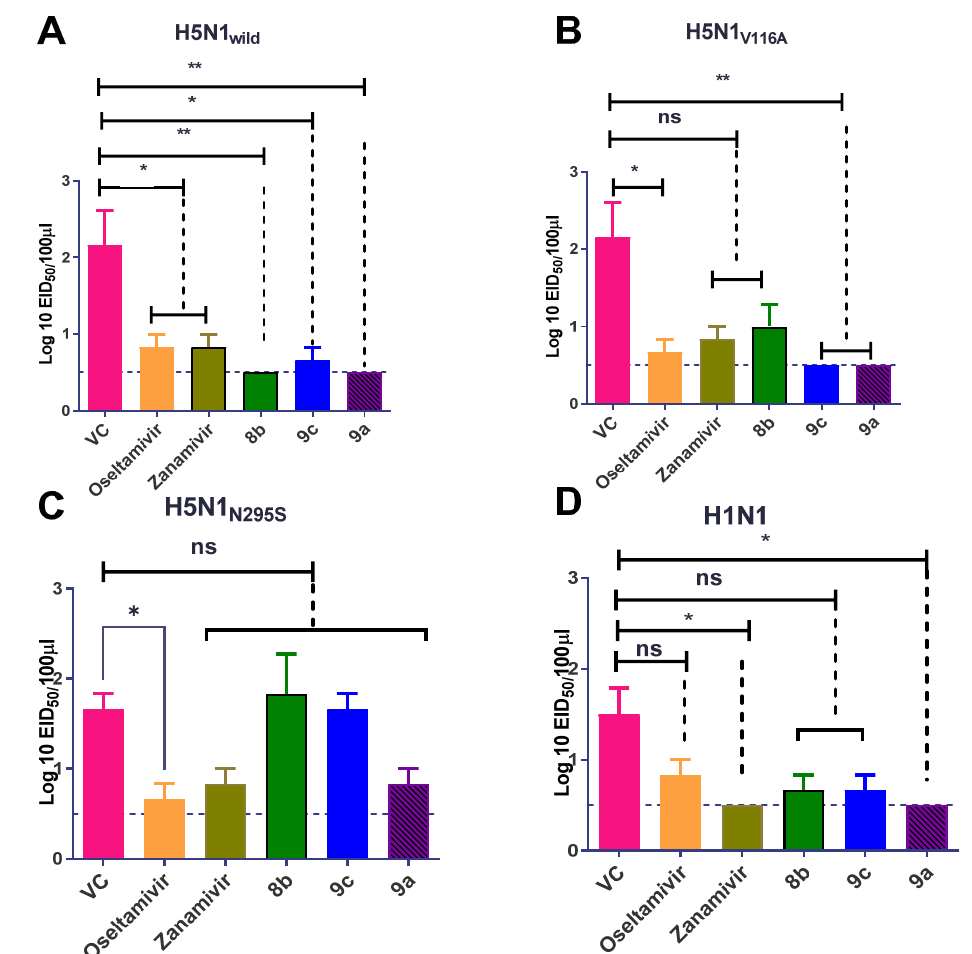
Figure 11. EID 50 titration of nasal washes to detect viral shedding after 5 dpi. ( A ) Synthetic compounds reduced the viral shedding more than oseltamivir and zanamivir after infection with H5N1 wild . ( B ) Synthetic compounds 9c and 9a reduced viral shedding from H5N1 V116A -infected cells more than oseltamivir and zanamivir. ( C ) 9a was the only synthetic compound that reduced the shedding of virus after infection with H5N1 N295S as well as zanamivir and oseltamivir. ( D ) Synthetic compounds reduced the viral shedding as well as zanamivir after infection with H1N1. The significant differences are indicated as follows: * p < 0.05, ** p < 0.01, and ns = non-significant.